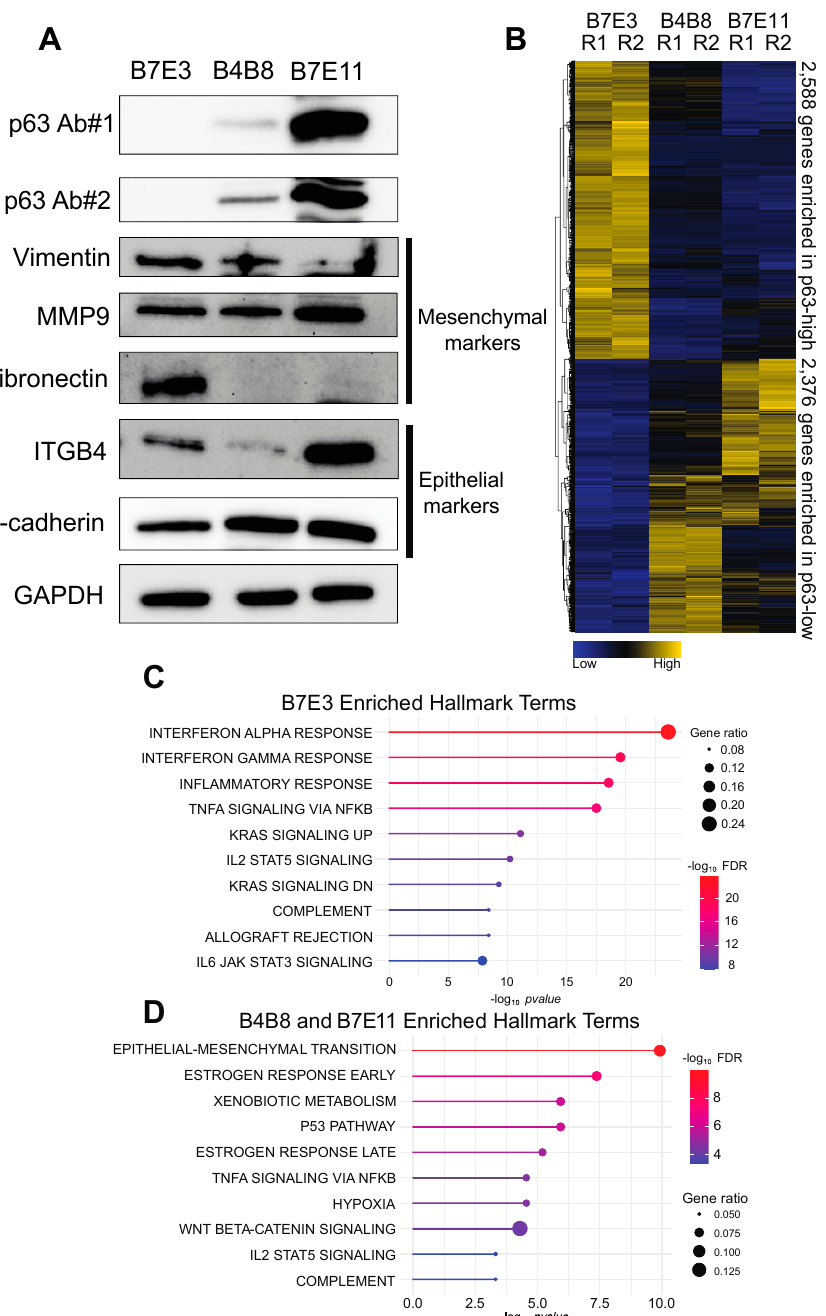
Figure 1. Profile of 4NQO-generated mOSCC cell lines. ( A ) Western blots for levels of p63 and EMT-associated factors in B7E3, B4B8, and B7E11 cell lines. ( B ) Heat map of the expression of genes consistently enriched in p63 high or p63 low cells. Enriched hallmark terms found in the p63 low B7E3 DEGs ( C ), the p63 high B4B8, and B7E11 DEGs ( D ).